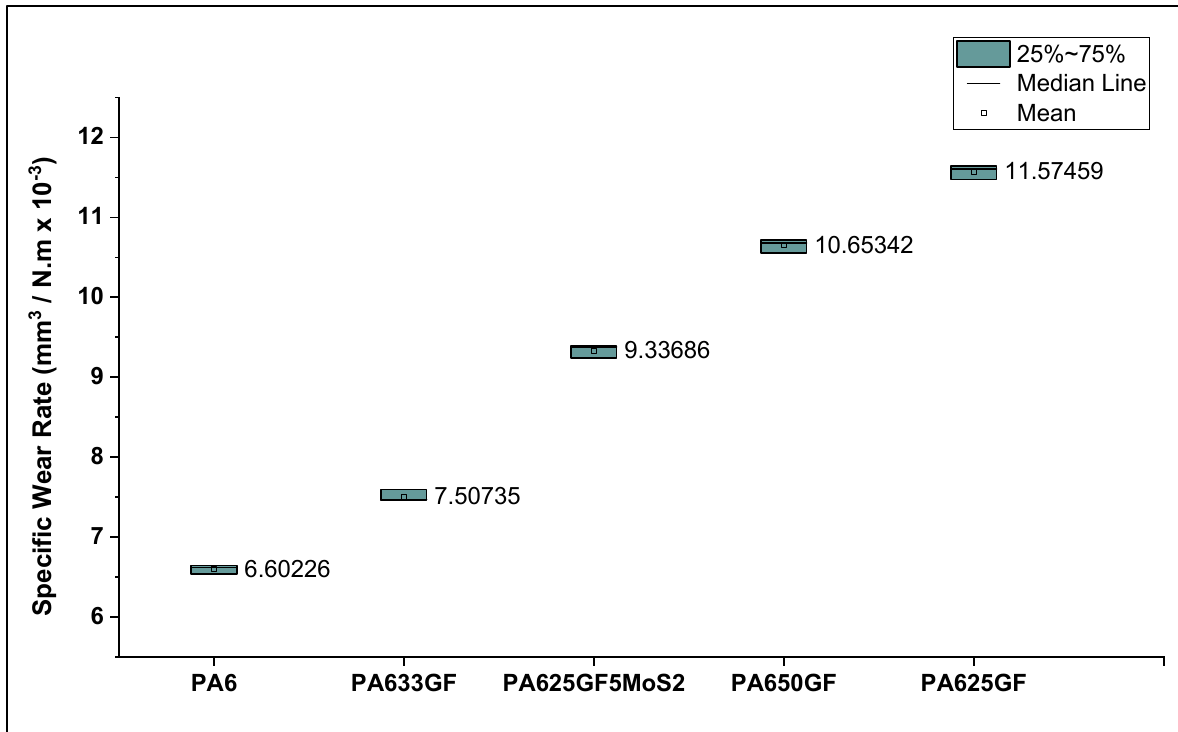
Figure 10. Specific wear rate of PA6 reinforced with glass fibres at varied fibre volume fractions .